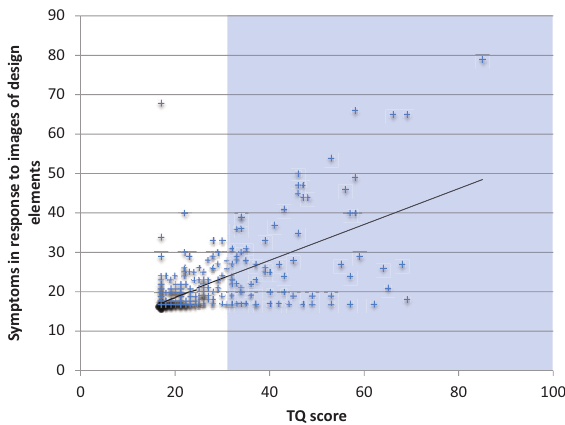
Figure 5. Number of symptoms in response to images of design elements as a function of the number of symptoms in response to the lotus seed pod and honeycomb (i.e. TQ